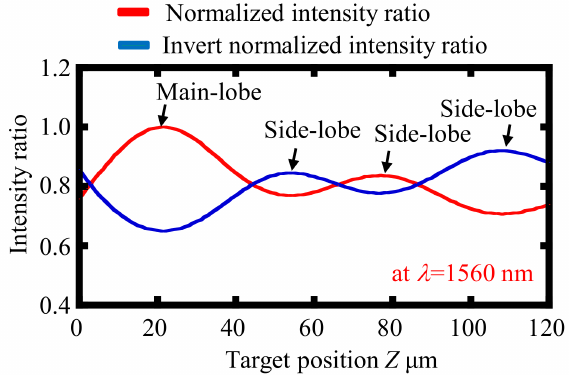
Figure 3. A typical axial response obtained by the dual-detector chromatic confocal probe with a mode-locked femtosecond laser source with axial response of the normalized intensity ratio and axial response of the invert normalized intensity ratio, with target positions ranging from 0 to 120 µ m and a defocus d of 110 µ m.